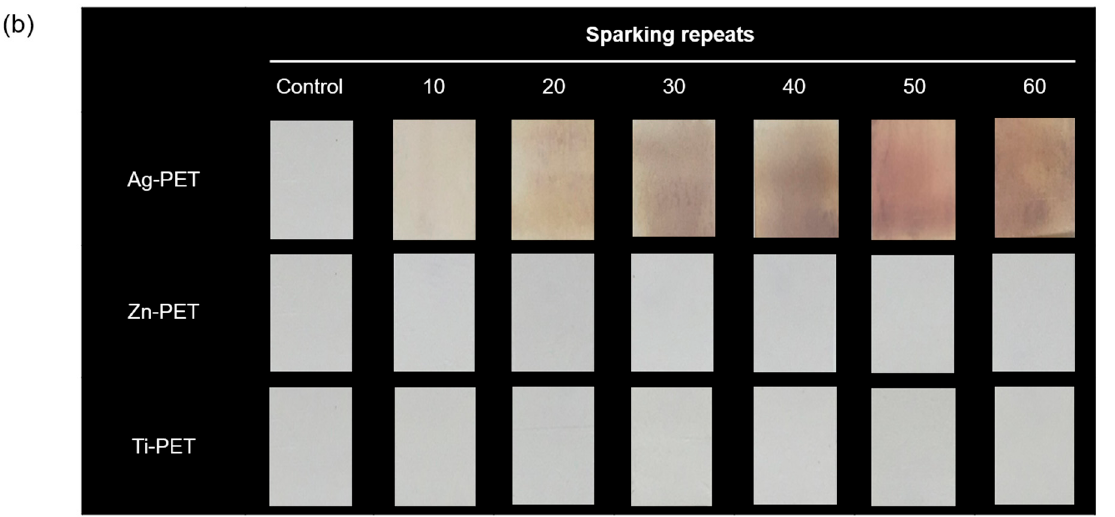
Figure 5. L*, a*, b* values ( a ) and visual images ( b ) of the Ag-PET, Zn-PET, and Ti-PET films treated 0–60 times.